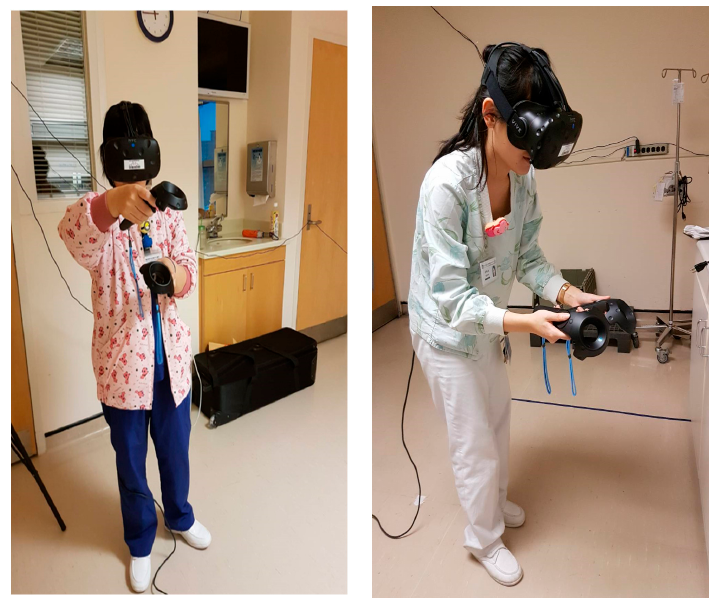
Figure 3. The learners’ actual operation process of the virtual reality learning system in two locations.